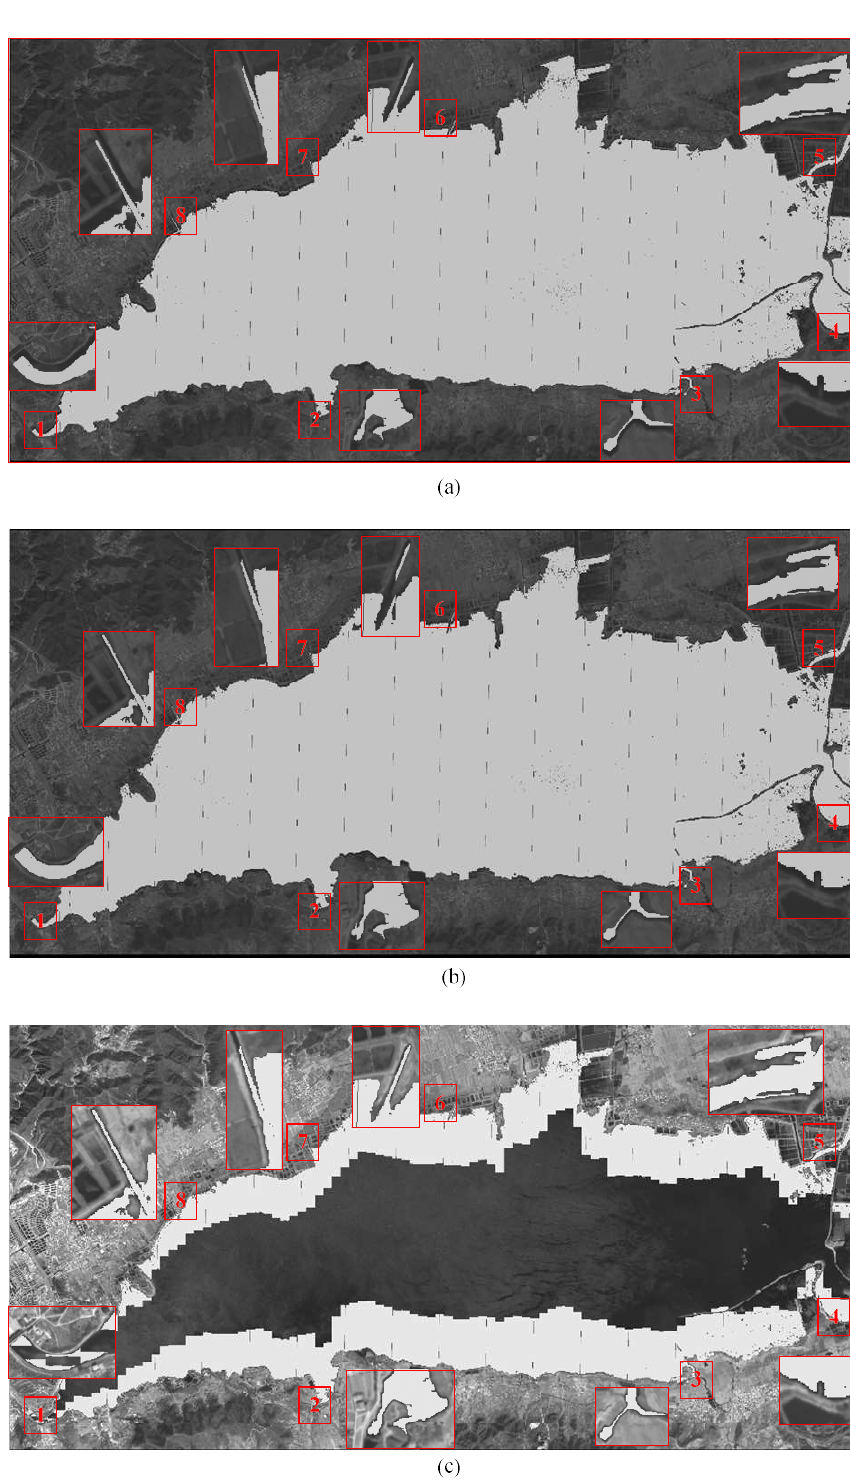
Figure 12. The image pair block 2 ROI matching results. ( a ) Block matching. ( b ) Sub-block matching. ( c ) End-block matching.